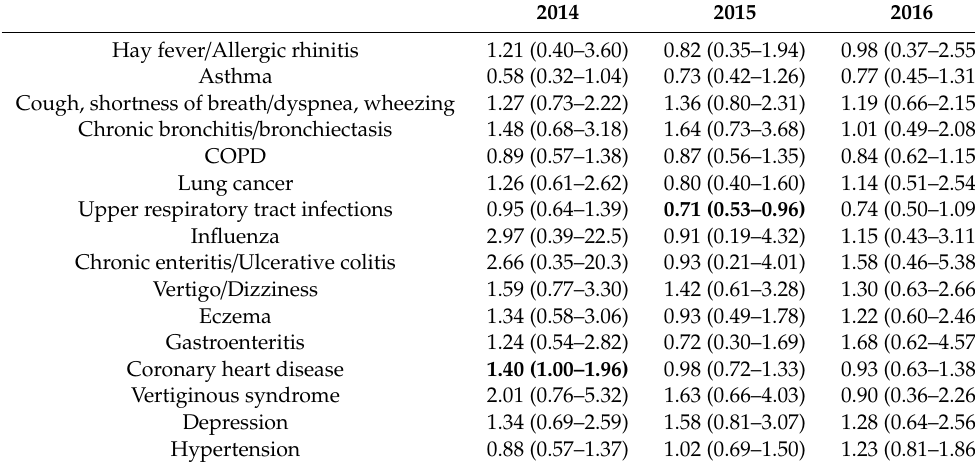
Table A9. Differences (OR, 99% CI) a per year in various comorbid conditions between livestock dense areas and control areas among elderly patients with pneumonia b (statistically significant results in bold)